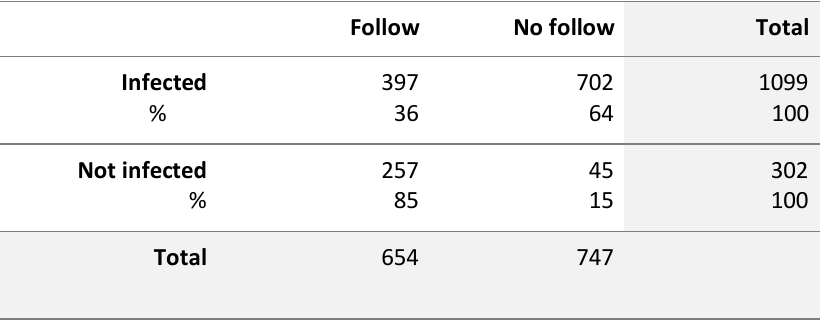
Table 3. Number of Catalan users by infected and following official accounts. Below we include the percentage for